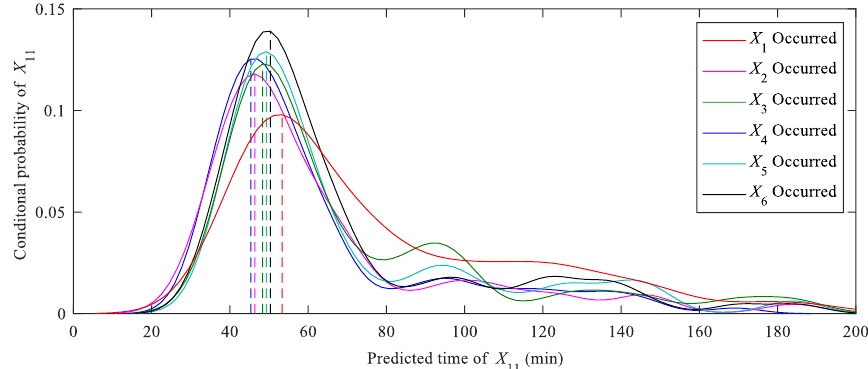
Aerospace 2022 , 9 , x 14 of 19 Figure 4. Estimated off-block time of FGHP with node updating from X 1 to X 6 ). Figure 4. Estimated off-block time of FGHP with node updating from 1